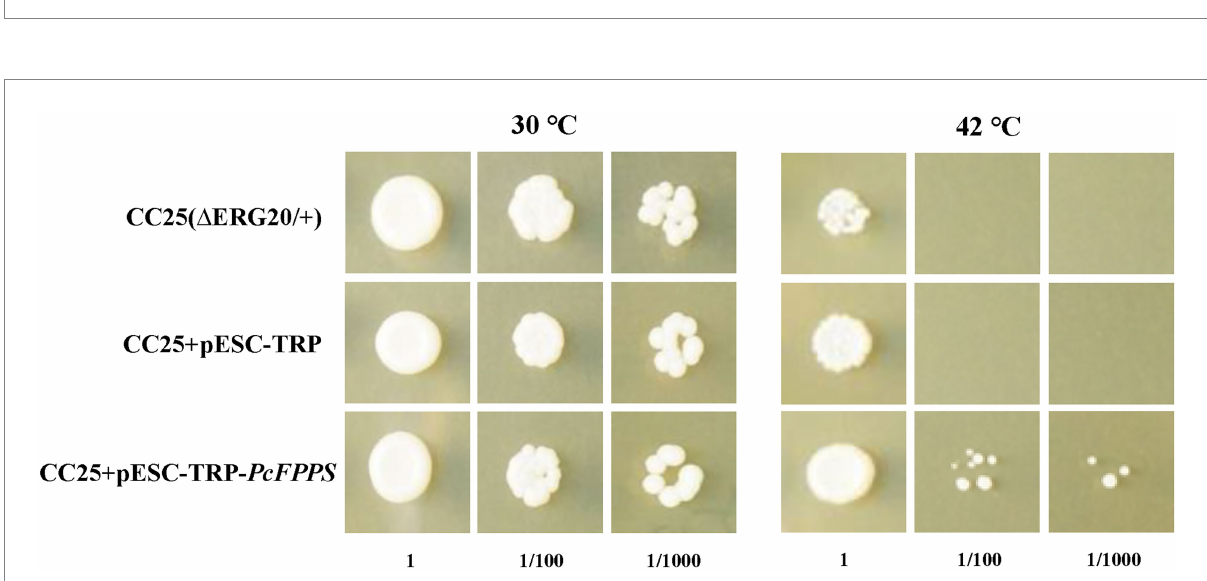
FIGURE 3 Functional complementation of PcFPPS in mutant yeast strain CC25 (MATa/MATalpha, Derg20/+). The growth testing and evaluation of strain CC25( ∆ ERG20/+), empty vector transformed CC25(CC25 + pESC-TRP) and pESC- PcFPPS transformed CC25(CC25 + pESC-TRP- PcFPPS ) were carried out in parallel at appropriate temperature of 30 ° C and nonpermissive high temperature of 42 ° C for 16 h. Then the yeast growth was observed after culturing at 37 ° C for 2